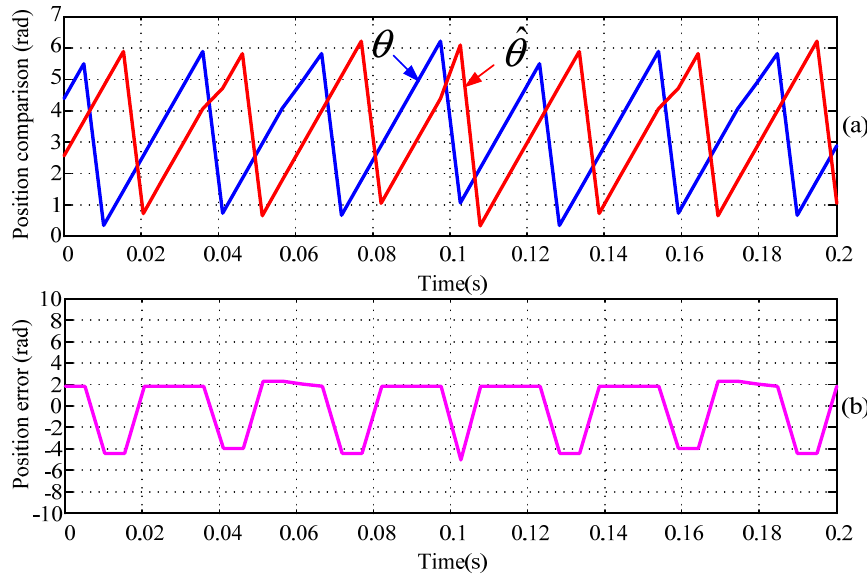
θ θ ) and rotor angle ) and rotor angle